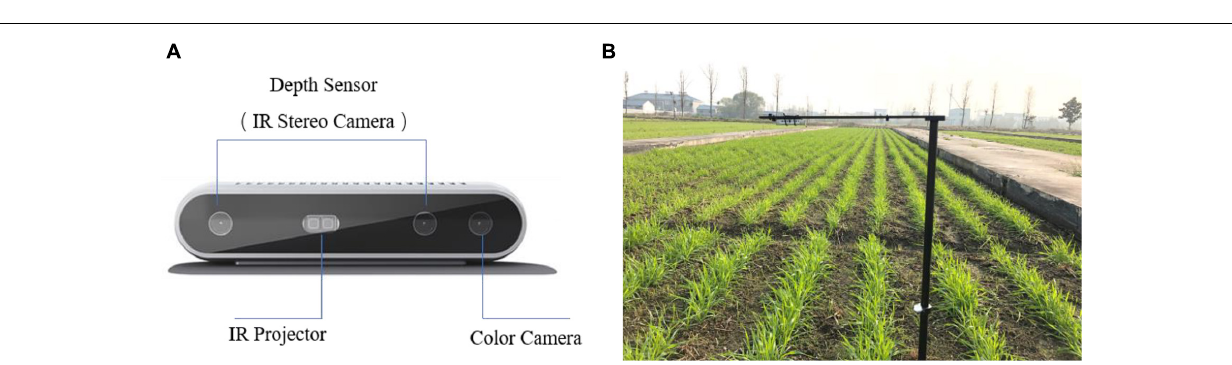
RGB images, both with a resolution of 1,280 × 720. RGB